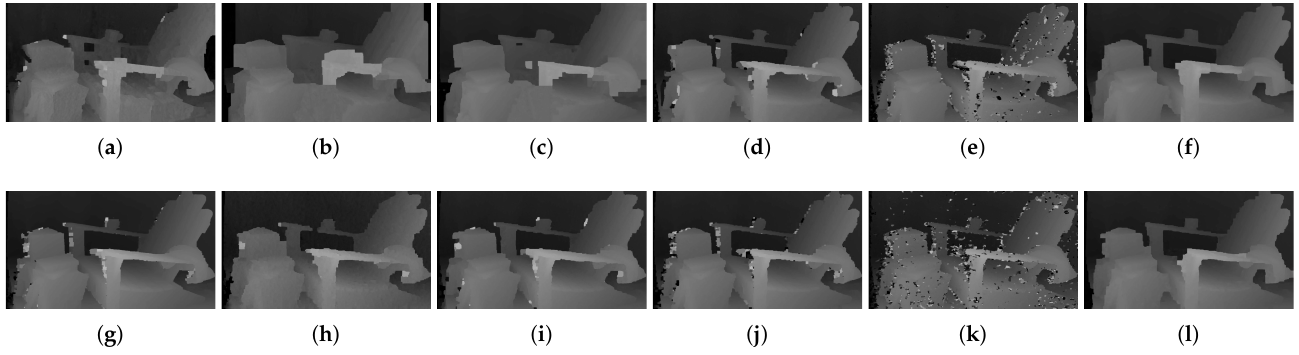
Figure 16. Estimated disparity images of the combinations of cost and image filter using the GC stereo method, according to the low and high pattern contrast parameters. The images in the top row show disparities at low contrast, and the images in the bottom row show those at high contrast, respectively. ( a ) GC, AD. ( b ) GC, Mean/AD. ( c ) GC, LoG/AD. ( d ) GC, BilSub/AD. ( e ) GC, Rank/AD. ( f ) GC, Census. ( g ) GC, AD. ( h ) GC, Mean/AD. ( i ) GC, LoG/AD. ( j ) GC, BilSub/AD. ( k ) GC, Rank/AD. ( l